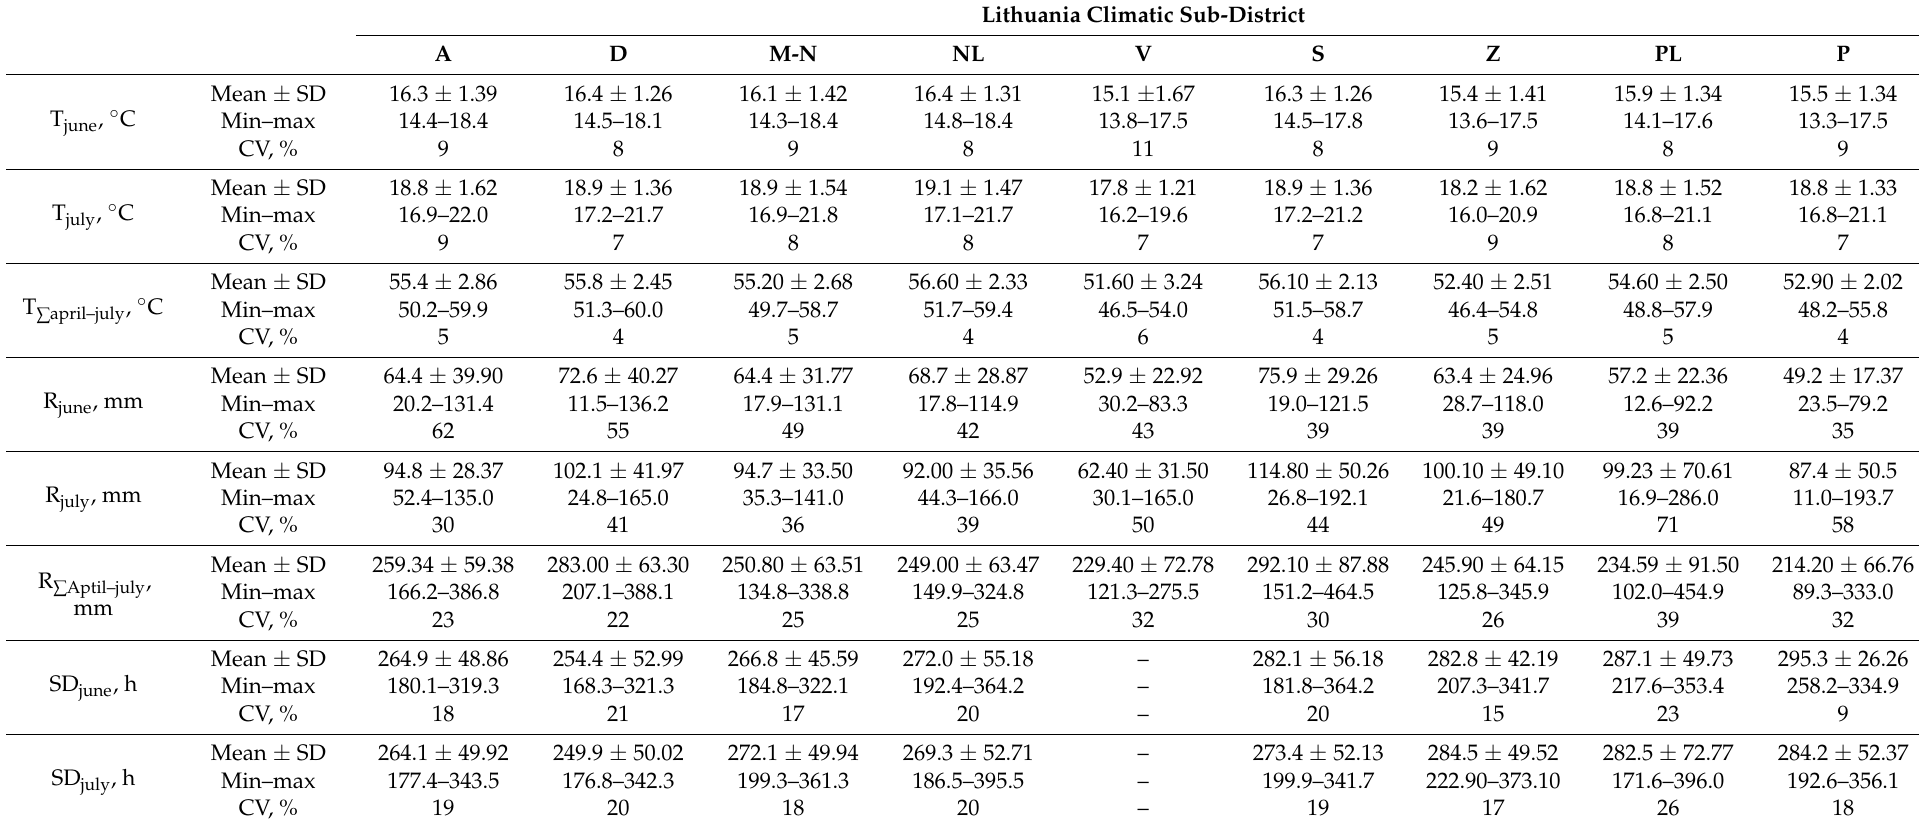
Table 6. Descriptive statistics of temperature (T), rainfall (R), sunshine duration (SS) and photosynthetically active solar radiation (PAR) in Lithuania climatic sub-districts in 2006–2016. Climatic sub-districts marking: Aukštaitija—A, Dz¯ukija—D, M¯uša-Nev˙ežis—M-N, the Nemunas Lowland—NL, Venta—V, S¯uduva—S, Žemaiˇciai—Z, Paj¯uris Lowland—PL, Paj¯uris—P. In Venta climatic sub-district temperature data are in 2012–2016; rainfall data—2008 and 2013–2016; in Aukštaitija climatic sub-district PAR data are in 2013–2016, in M¯uša-Nev˙ežis and Venta climatic sub-districts PAR data are 2008–2016. The lines in the table means that data